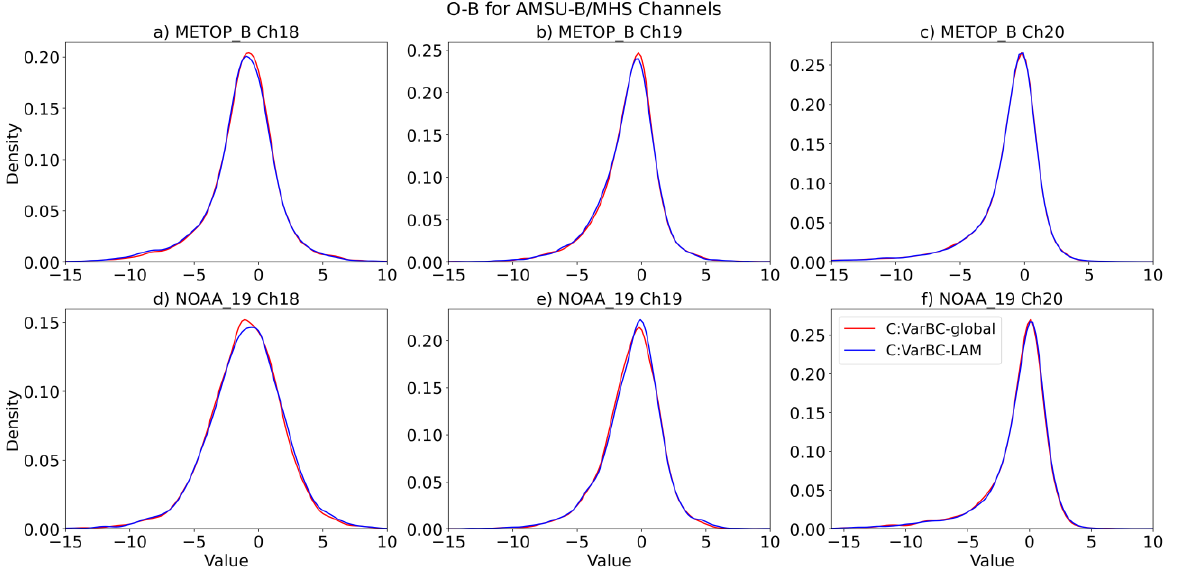
Figure 6. Density function of the O-B differences for the MHS ( a – c ) and AMSU-B ( d – f ) channels in ACCESS-C for the experiments VarBC-global (red) and VarBC-LAM (blue) during February 2020.